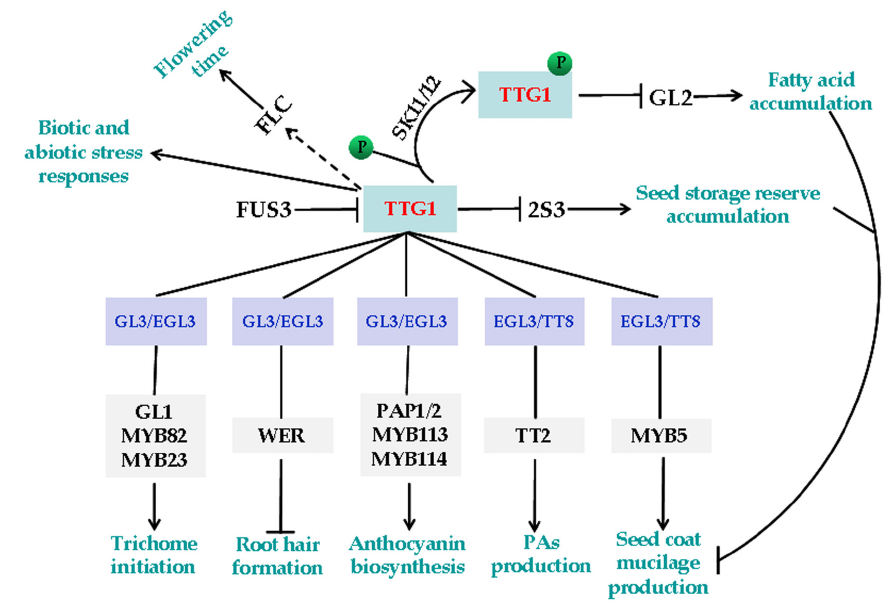
Figure 1. The functions of TTG1. TTG1 regulates cell fate determination and secondary metabolism by forming MBW complexes with specific R2R3 MYB and bHLH transcription factors. The TTG1-GL3 / EGL3-GL1 / MYB23 / MYB82 complexes regulate trichome initiation [25,30,60,61], the TTG1-GL3 / EGL3-WER complexes regulate root hair formation [27,33], the TTG1-GL3 / EGL3-PAP1 / 2 / MYB113 / 114 complexes regulate anthocyanin biosynthesis [24,34,36], the TTG1-EGL3 / TT8-TT2 complexes regulate proanthocyanidins (PAs) biosynthesis [24,28,34], and the TTG1-EGL3 / TT8-MYB5 complexes regulate seed coat mucilage production [24]. TTG1 compromises the accumulation of seed storage reserves through inhibiting 2S3, and FUS3 can directly suppress the expression of TTG1 . SK11 / 12 can phosphorylate TTG1, therefore inhibit GL2 expression, and a ff ect fatty acid accumulation. TTG1 is also involved in regulating flowering, as well as biotic and abiotic stress responses.